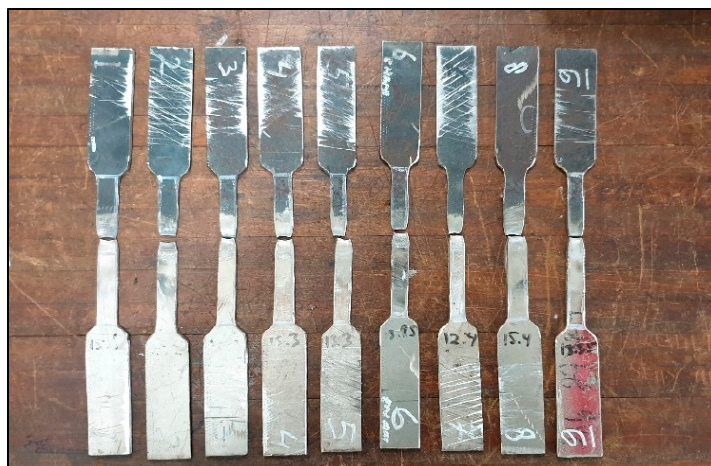
Figure 4. Tensile test samples of SS316 and low-carbon steel.